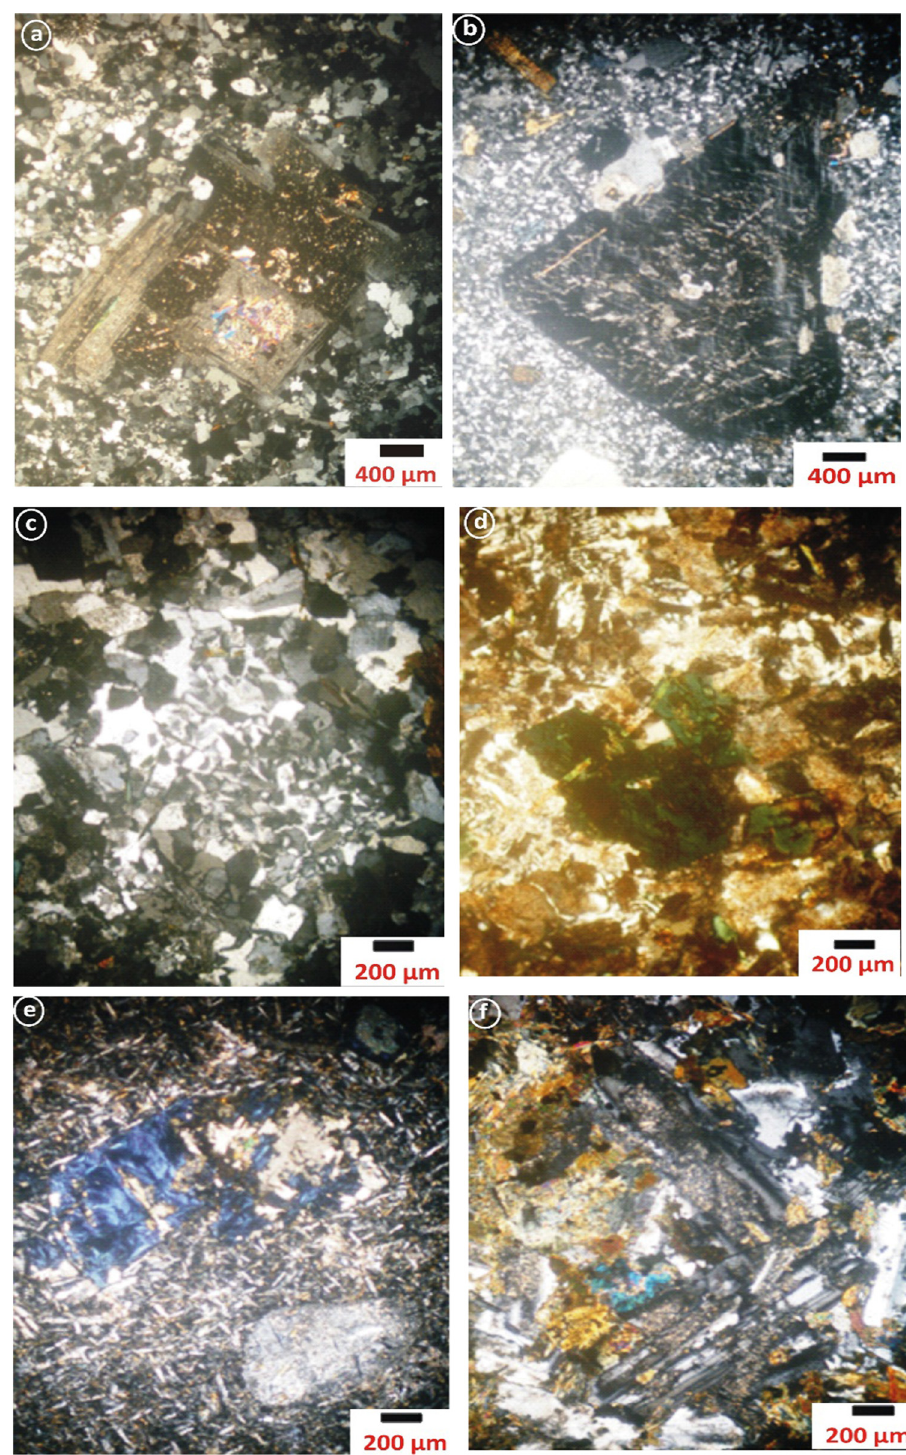
Figure 3: Photomicrographs of ( a ) porphyritic dacite dike showing pericline twinning in the phenocryst of plagioclase ( C.N. ) ; ( b ) micro - granite dike showing phenocryst of microcline micro perthite ( C.N. ) ; ( c ) granophyre dike showing graphic texture ( C.N. ) ; ( d ) alkaline granophyre dike showing riebeckite crystals ( C.N. ) ; ( e ) basaltic dike showing blue pennite type of chlorite and fi ne - grained lathes plagi - oclase ( C.N. ) ; ( f ) dolerite dike showing characteristic dolerite and intergranular texture ( C.N. )